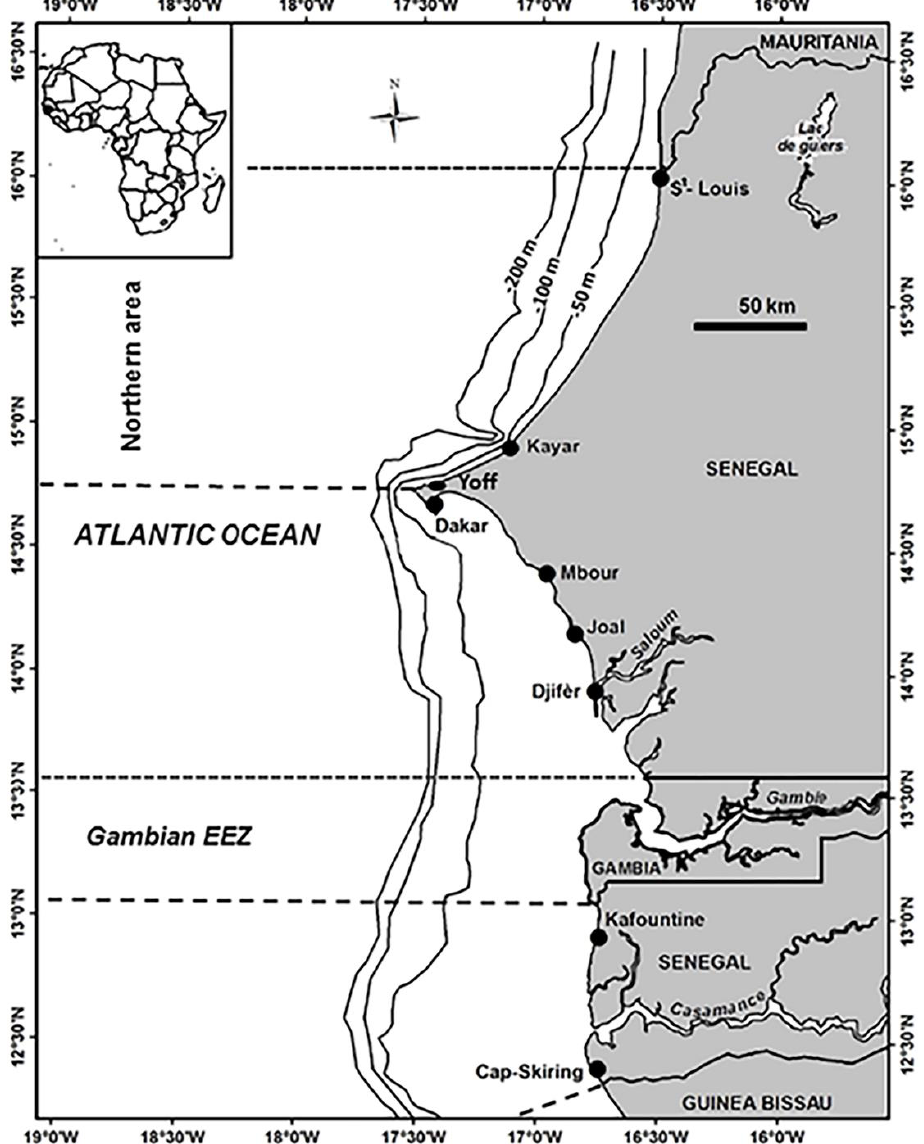
Figure 1. Map of the study area with the localization of sampling stations corresponding to the main landing ports along the Senegal coast. The Northern section includes Saint-Louis, Kayar, and Yoff.